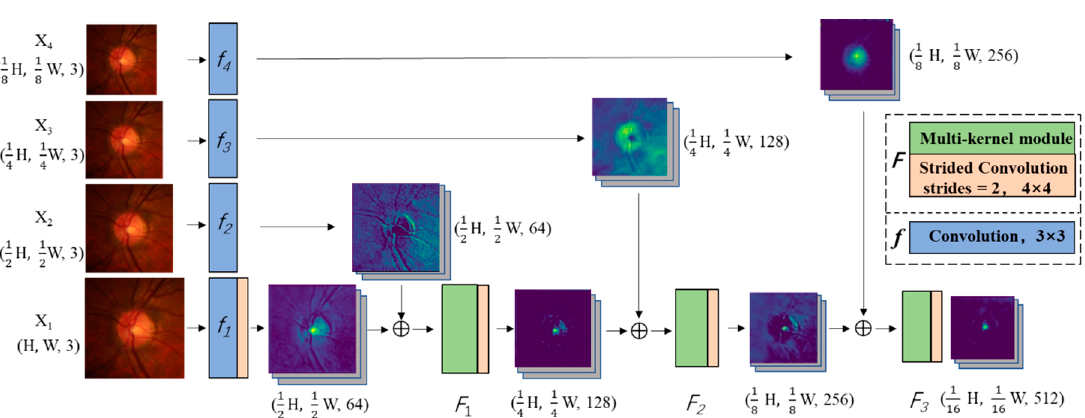
Figure 3. Schematic diagram of feature extraction in the contracting path of optic cup (OC) segmentation.